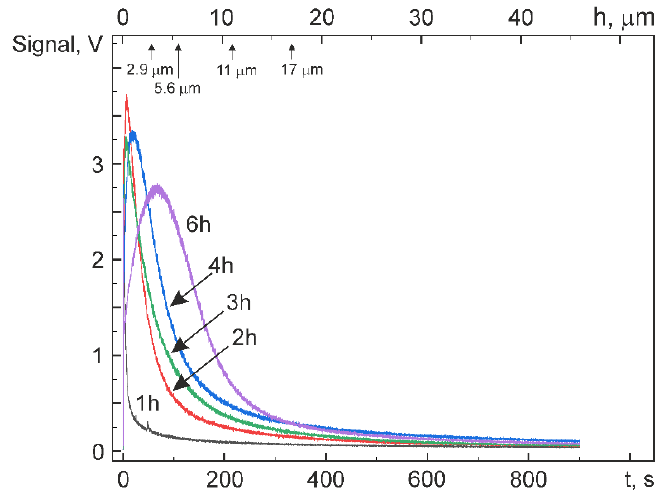
Figure 4. Qualitative profiles of signal distribution due to hydrogen atoms vs. sputtering time in Ti 49.4 Ni 50.6 (at%) after electrolytic hydrogenation in normal saline. (This figure is in color only in the electronic version.)